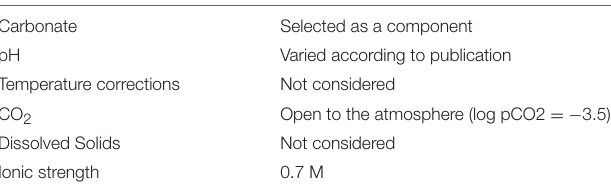
FIGURE 1 | Flow chart for study retrieval and selection. TABLE 1 | Parameters and assumptions used in MINEQL + for post-hoc pCu calculation.